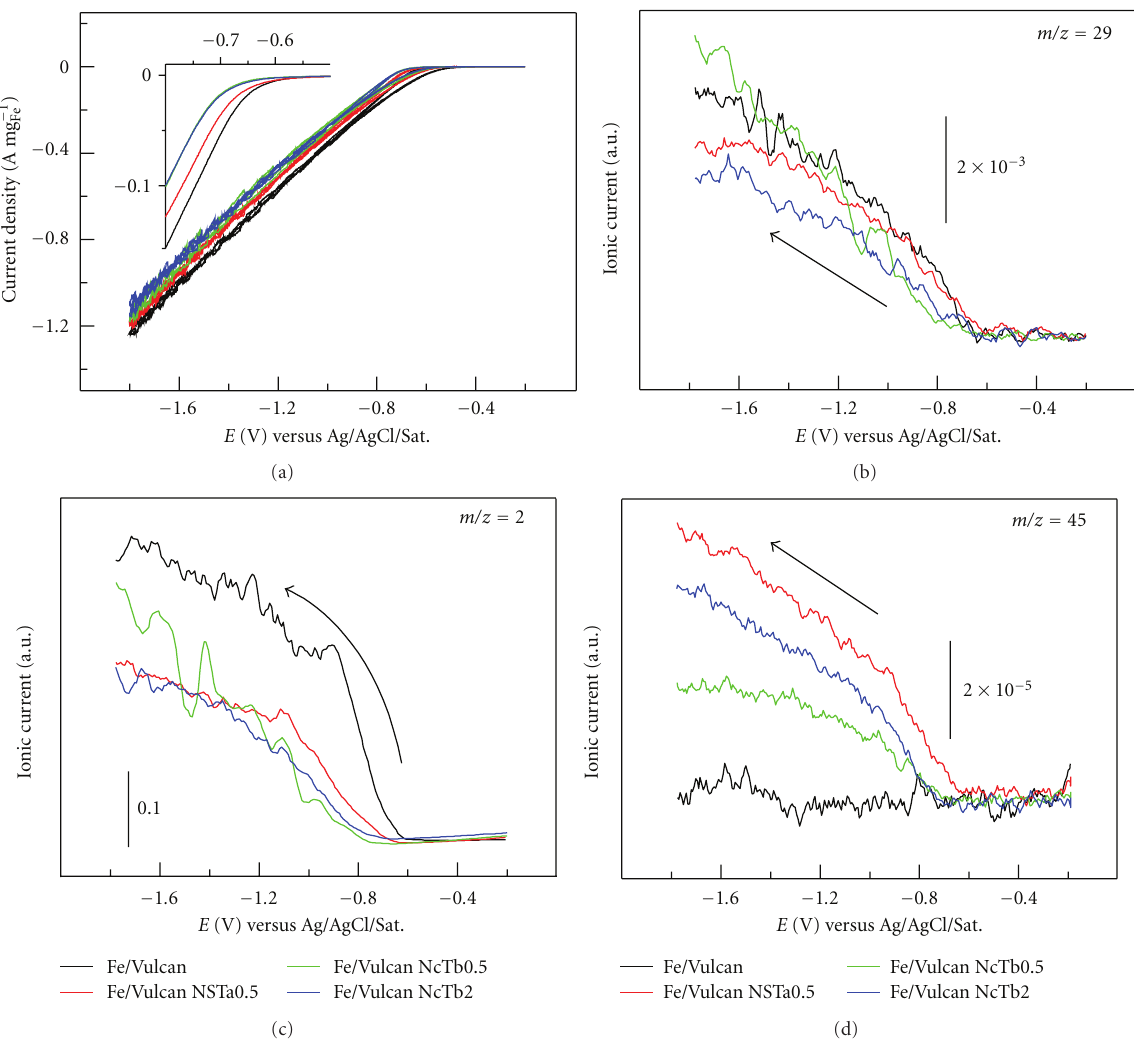
Figure 3: CVs and MSCVs for Fe/C catalysts in 0.5 M H 2 SO 4 (sweep rate 10 mVs − 1 , E i = − 0 . 2 V versus Ag/AgCl/Sat.). Inset shows a zoom of the onset potential region during the cathodic